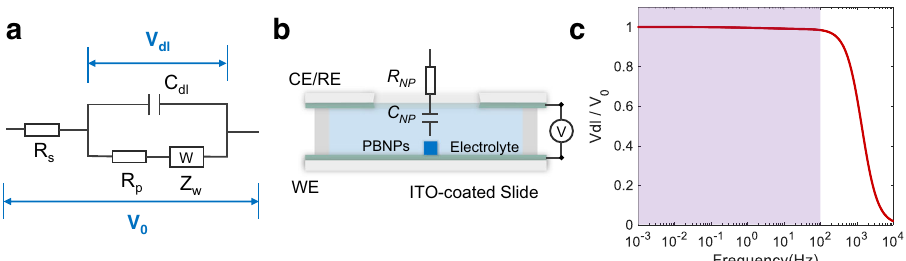
Fig. 4 Theoretical analysis of the equivalent circuit. a Randles-like circuit for the entire PBNPs-deposited ITO electrode. b Equivalent circuit consisting of a capacitor ( C NP ) and a resistor ( R NP ) to understand the oEIS of single PBNPs. c Within 0.01 − 100 Hz (purple region), nearly all the voltages from the potentiostat dropped at the electric double layer at the ITO-electrolyte interface, according to the conventional EIS analysis of the